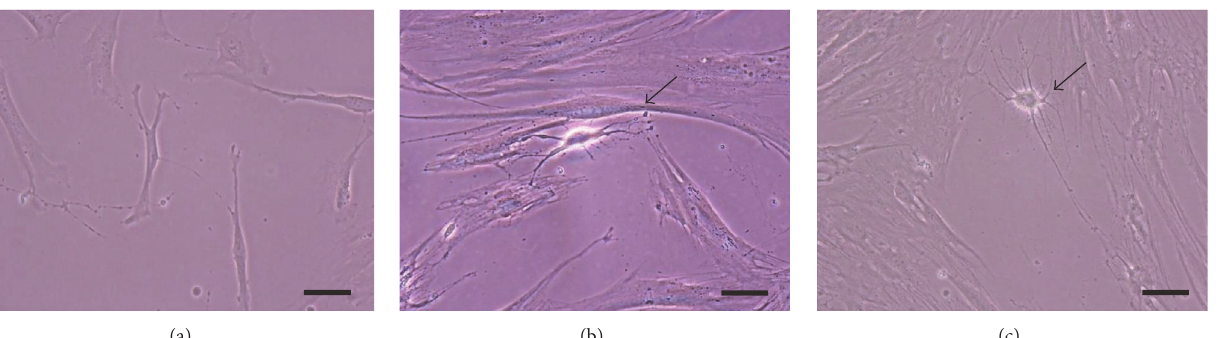
Figure 1: Morphologic findings of hDFCs during one-step neuronal differentiation. (a) Undifferentiated hDFCs (day 0). (b) hDFCs on day 3 after neuronal induction. (c) hDFCs on day 7 after neuronal induction. Scale bars = 50 𝜇 m. Arrows indicate neural stem cell-like cells.